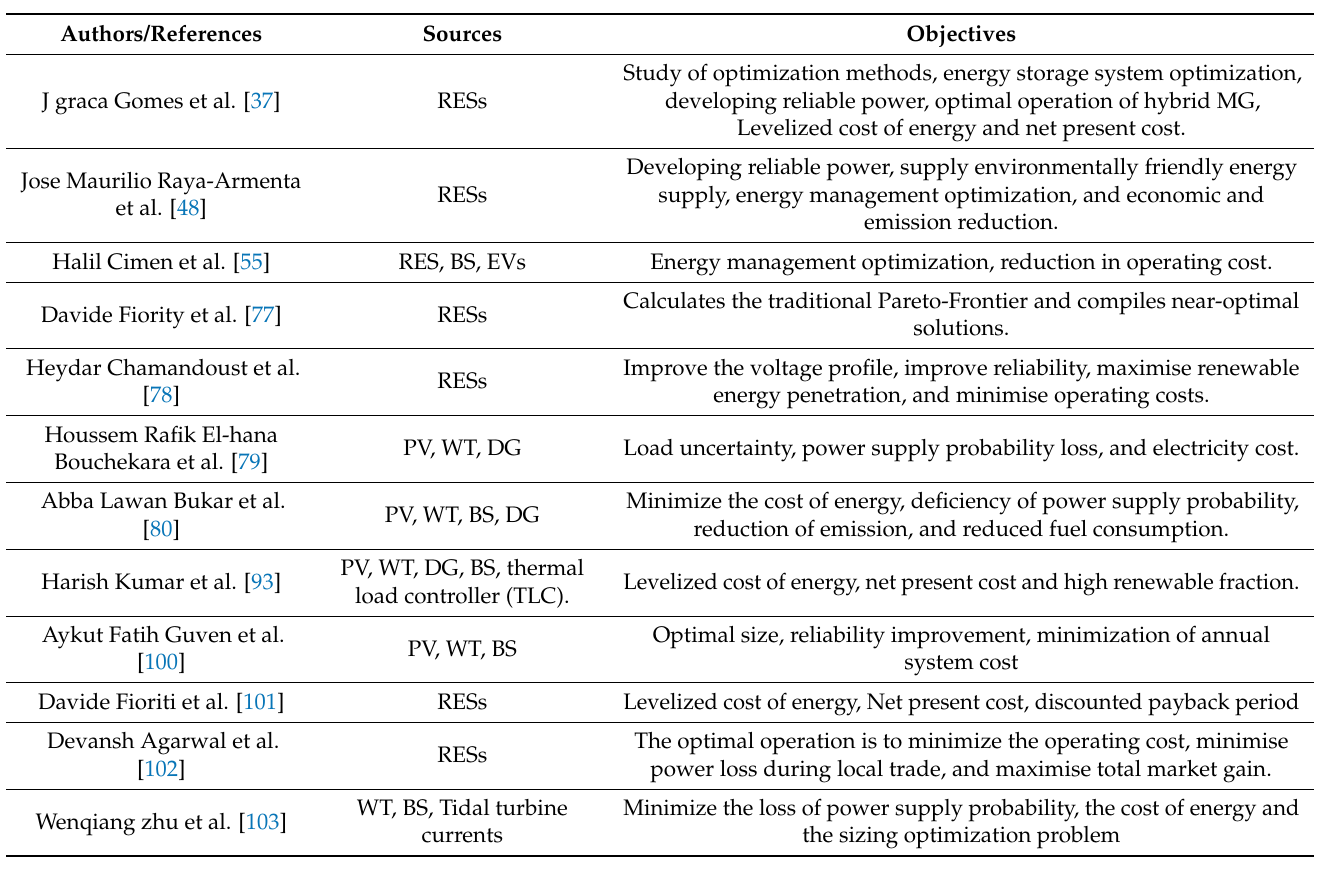
Table 3. Brief discussion on multi-objective optimization